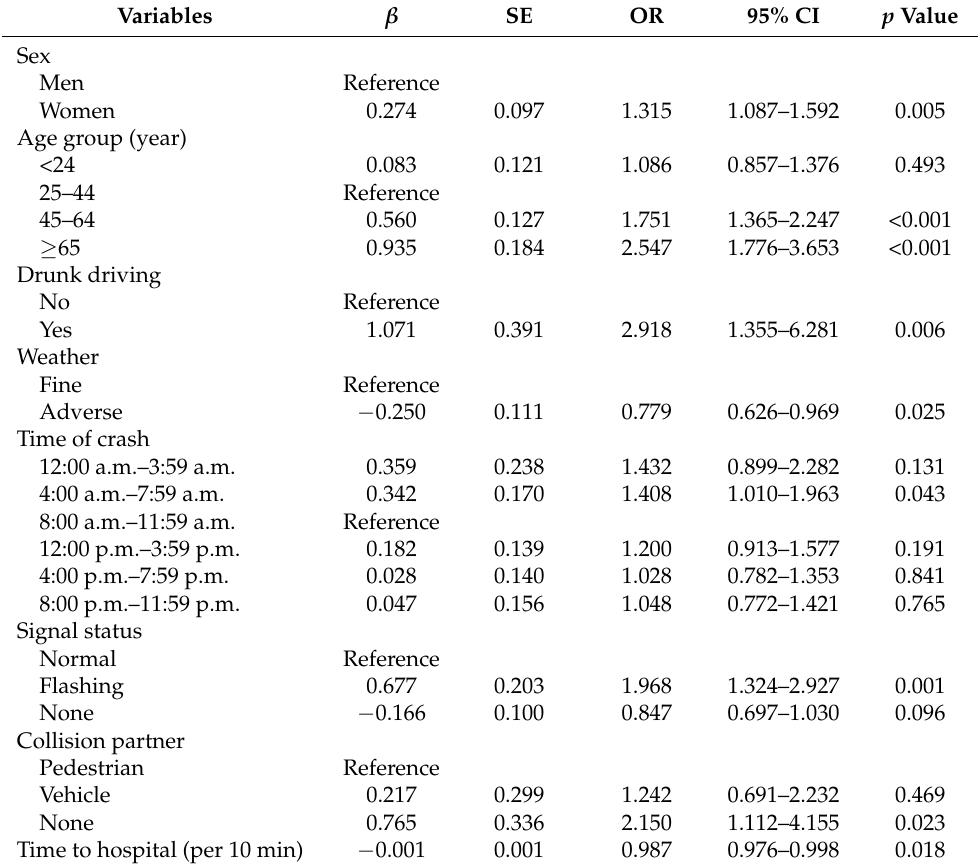
Table 2. Results of a multivariate analysis between independent variables and severe injury (ISS ≥